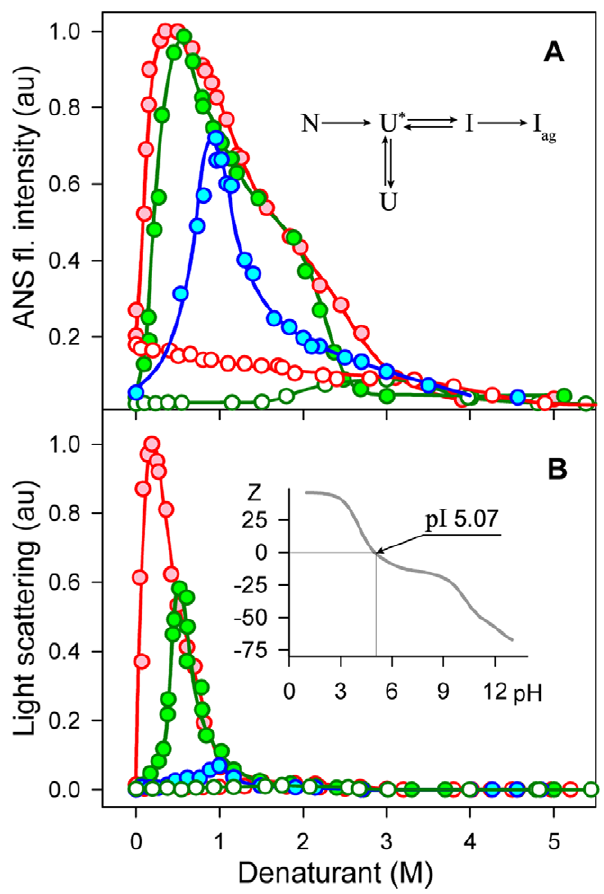
Figure 1. Actin aggregation induced by GdnHCl in low concentrations. The dependence of ANS fluorescence intensity ( A ) and of light scattering ( B ) of the solutions of inactivated actin (red) and initially native actin after 10 min and 24 h of incubation in a solution of denaturants at the appropriate concentration (blue and green) on GdnHCl (closed symbols) and urea (open symbols) concentration. Insert in panel A . Scheme of actin denaturation and aggregation (N, U * and I are native, essential unfolded and inactivated actin [11], I ag is aggregates of inactivated actin, the details are given in the text). Insert in panel B . The dependence of the total macromol- ecule charge of actin on the pH of a solution calculated on the basis of protein amino acid content [24]. The protein concentration was 0.15 mg/ml, ANS concentration was 5 ? 10 2 5 M.